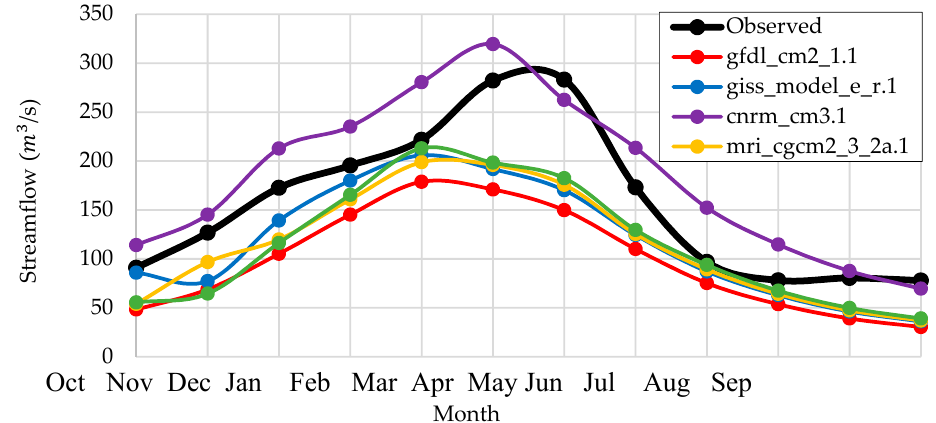
Figure 13. Impact of climate change on simulated streamflow of the Hemrin Watershed for the period from 2015 to 2050.